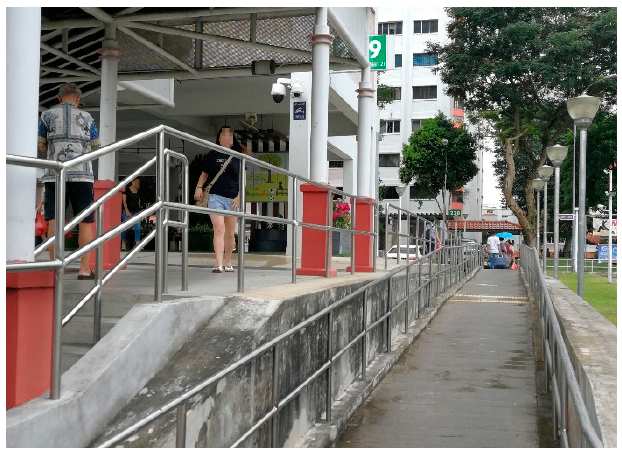
Figure 11. An unsheltered slope with pedestrians going back and forth to the market.